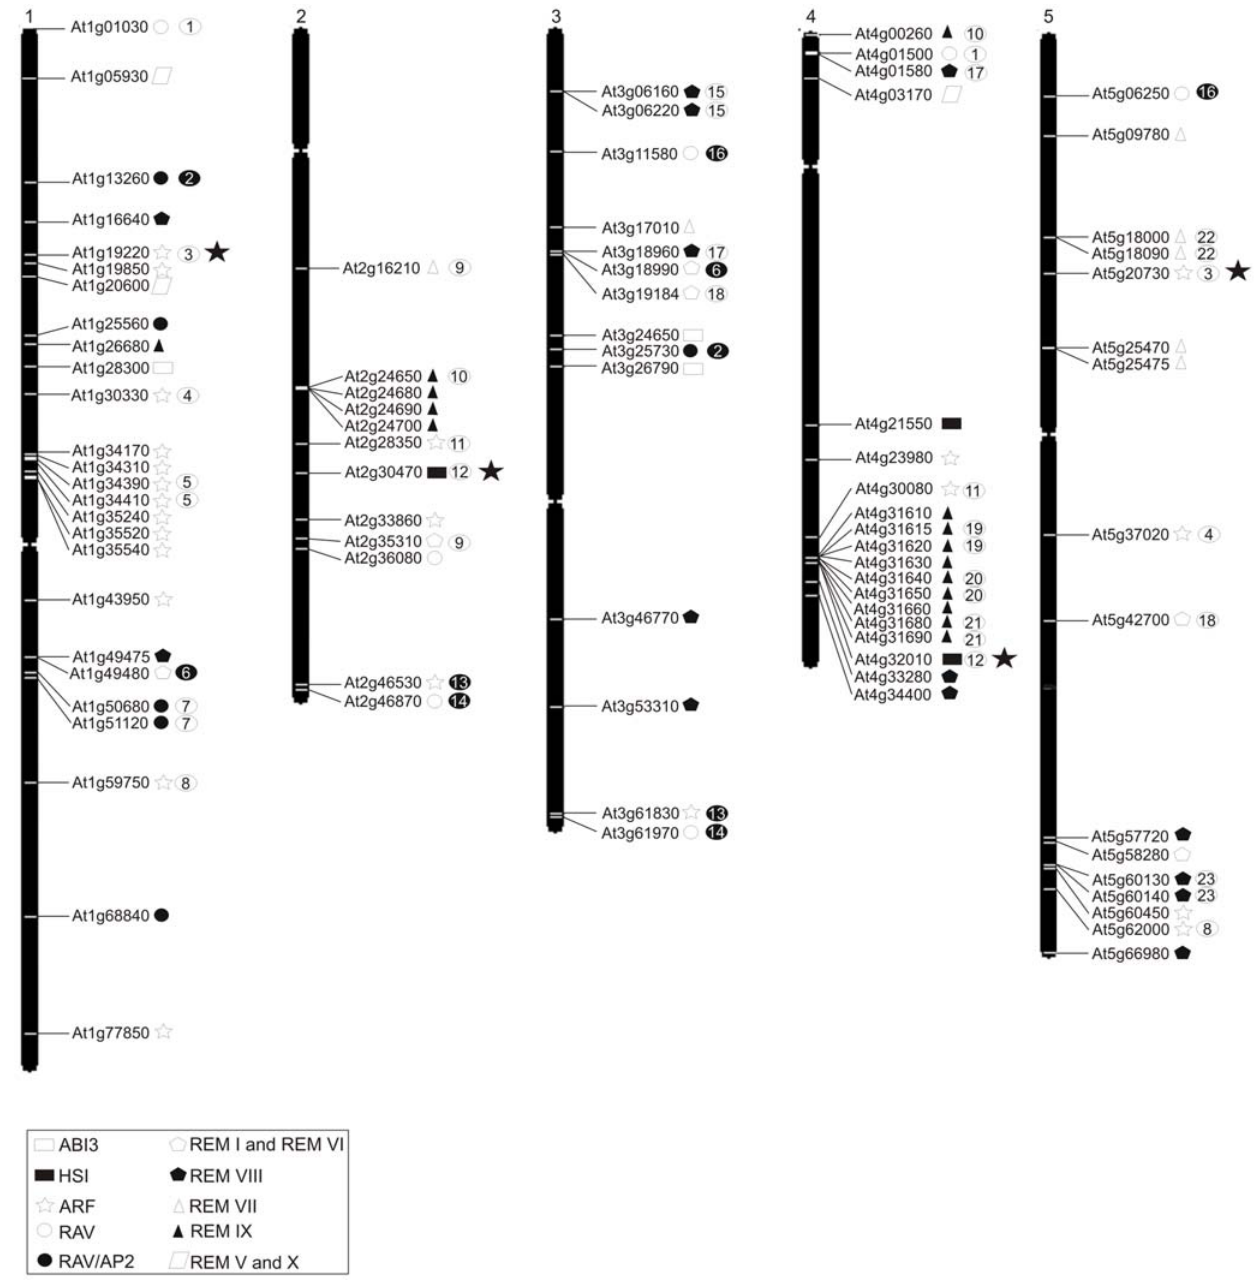
Figure 5. The locations of the B3 superfamily genes on the Arabidopsis chromosomes. The chromosome number is indicated at the top of each chromosome. The chromosomal positions of the B3 genes are indicated by their locus identifier. Families are shown with a box in the corresponding gene (see legends). Duplicated B3 genes identified by our study are designated by numbers in open circles. B3 genes that participated of the most recent duplicated segmental region studied by Blanc et al. [38] are identified by a number in solid black circles. B3 genes that suffered duplication according to our study and that were considered ancient duplicated genes studied by Blanc et al. [38] were marked by a black star.